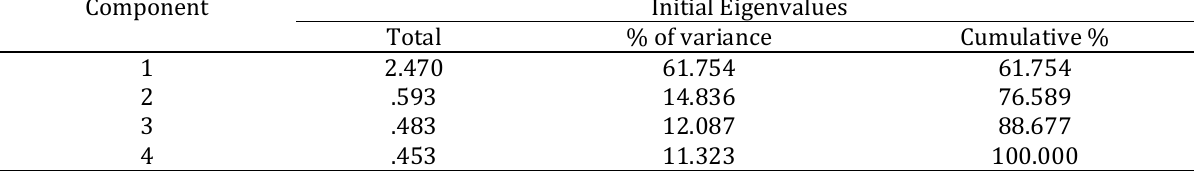
Table 7: Results of Eigen analysis of covariance matrix of the Robotics Variables Component